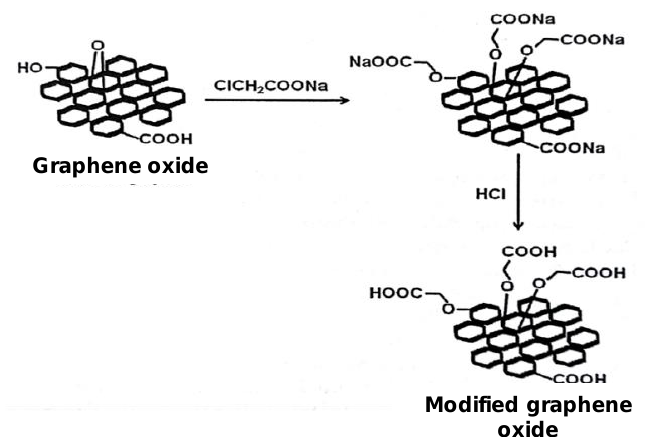
Figure 2. Schematic illustration of preparation of modified GO based on the Du et al. [31].